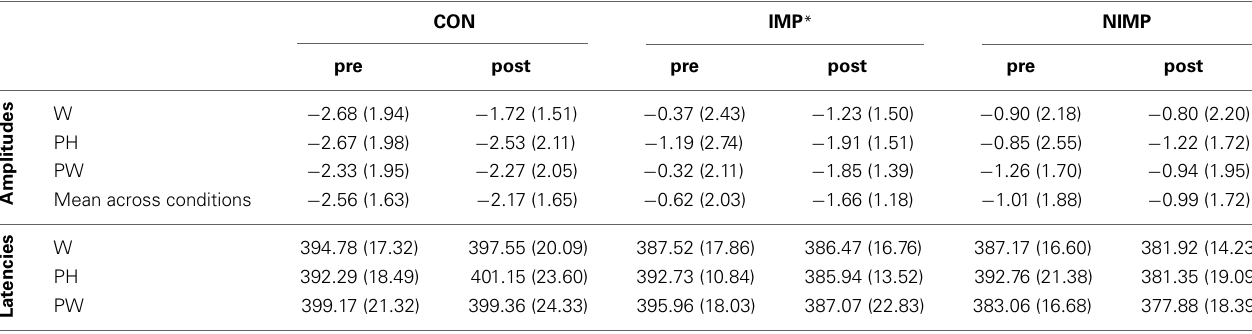
Table 3 | N400 mean peak amplitudes in μ V (SD) and latencies in ms (SD). CON IMP *